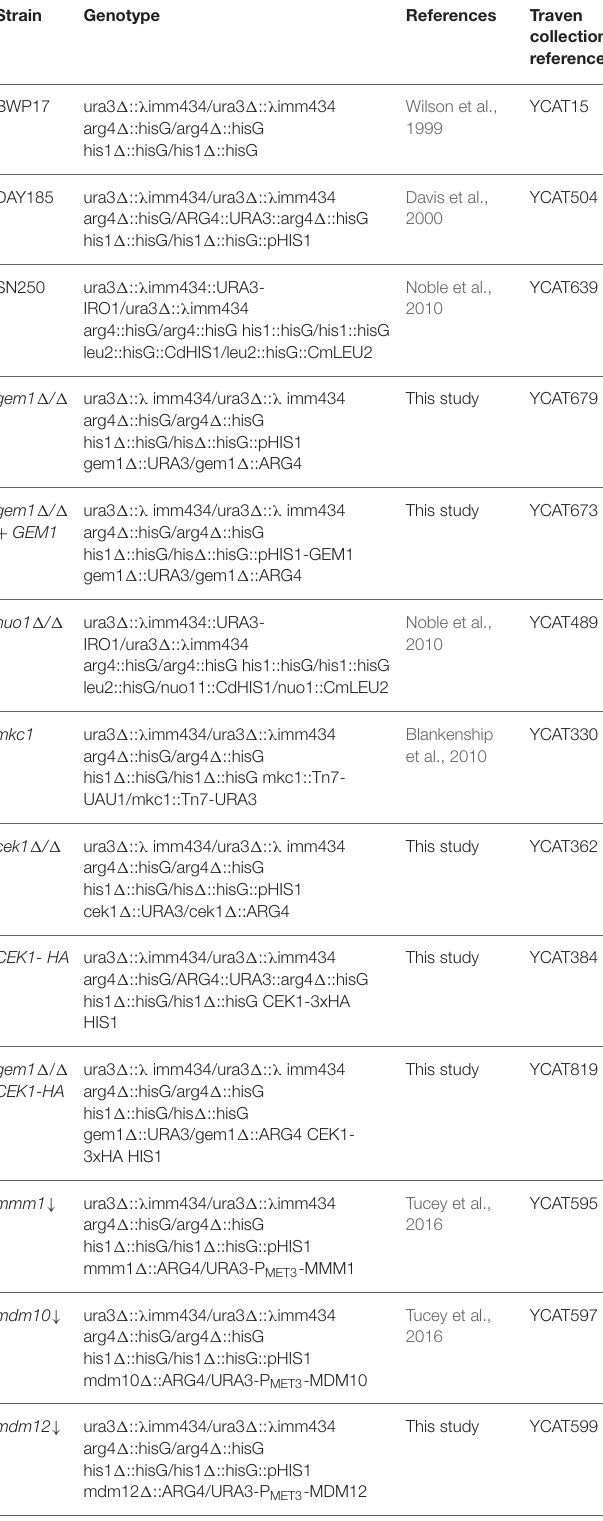
TABLE 1 | C. albicans strains used in this study. Strain Genotype